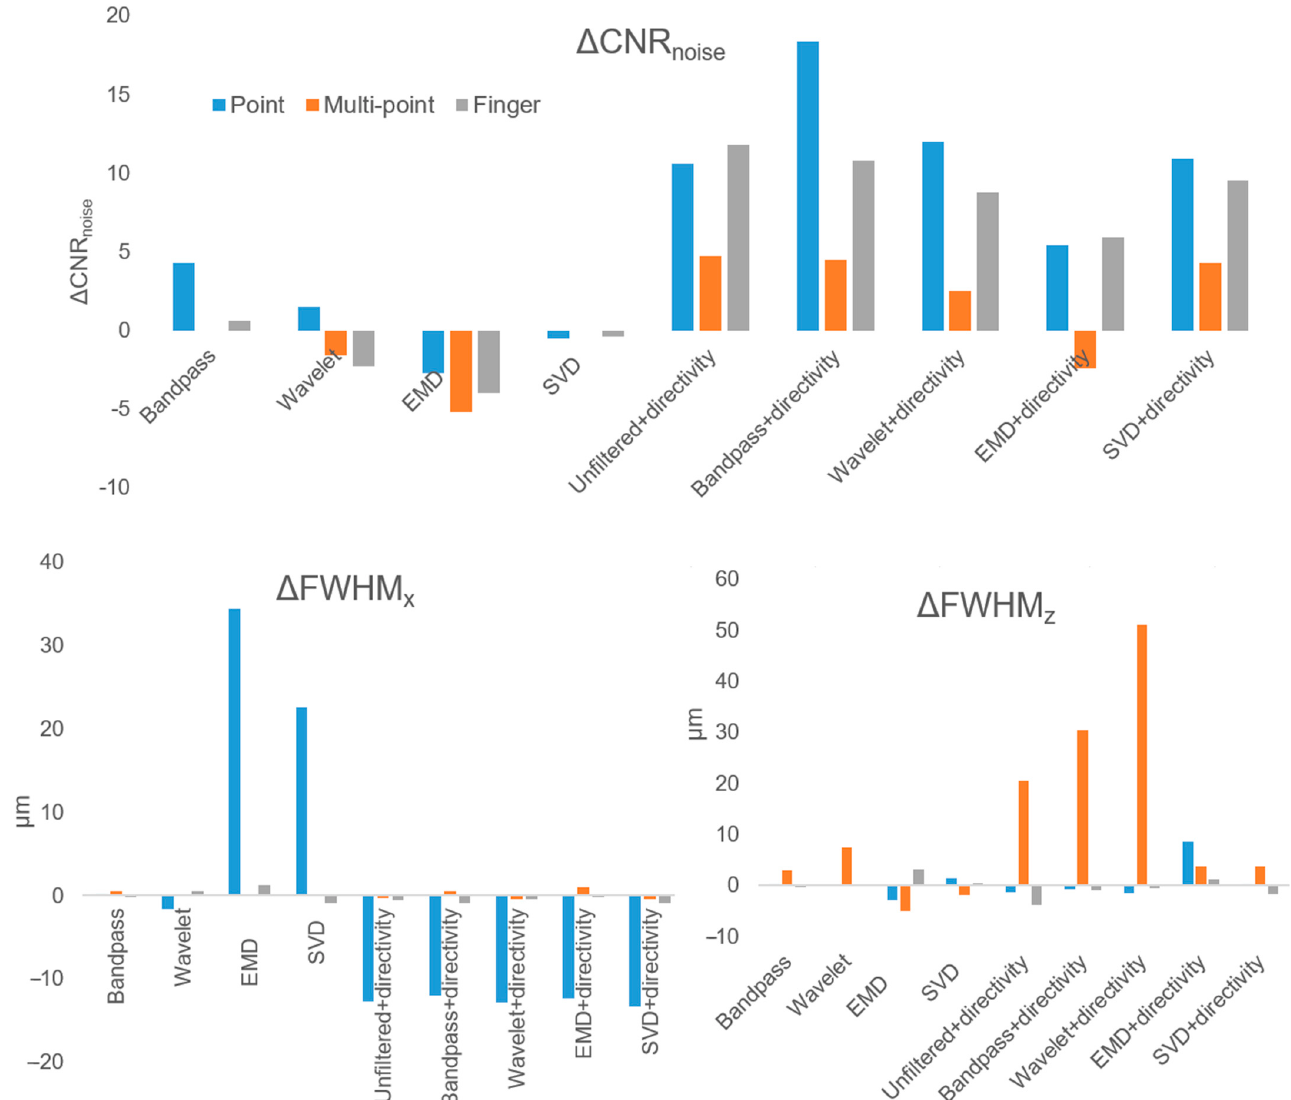
Figure 4. Comparison of the changes in CNR, FWHM x , and FWHM z from the unfiltered